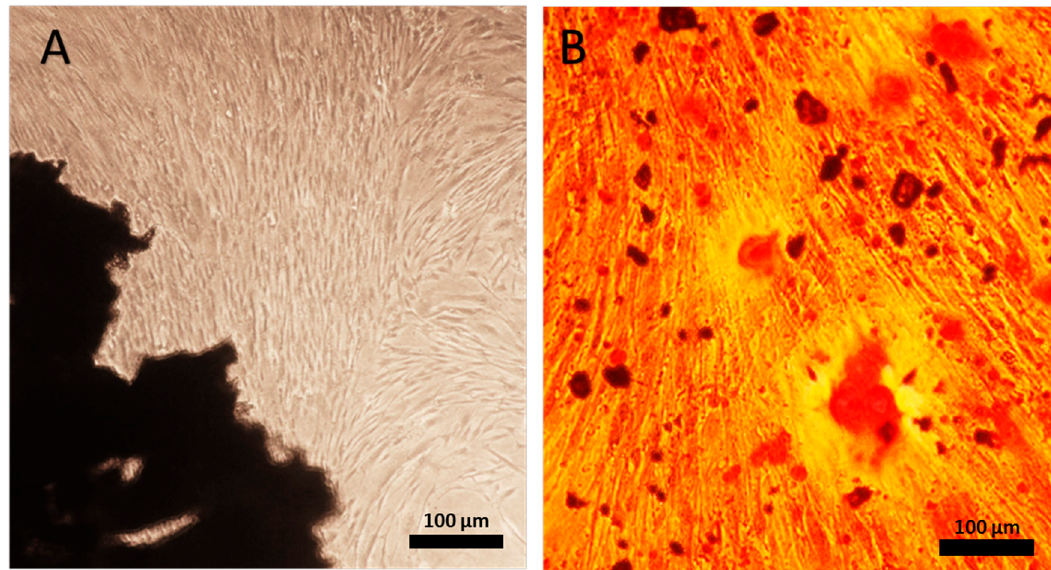
Figure 1. ( A ) Primary periodontal ligament cells (hPDLCs) extracted from periodontal ligament were cultured for 14 days. ( B ) Mineral deposition by hPDLCs after 10 days in osteogenic medium was observed by alizarin red staining. Magnification, ×10 for A; Magnification, ×40 for B. The scale bar represents 100 µm.